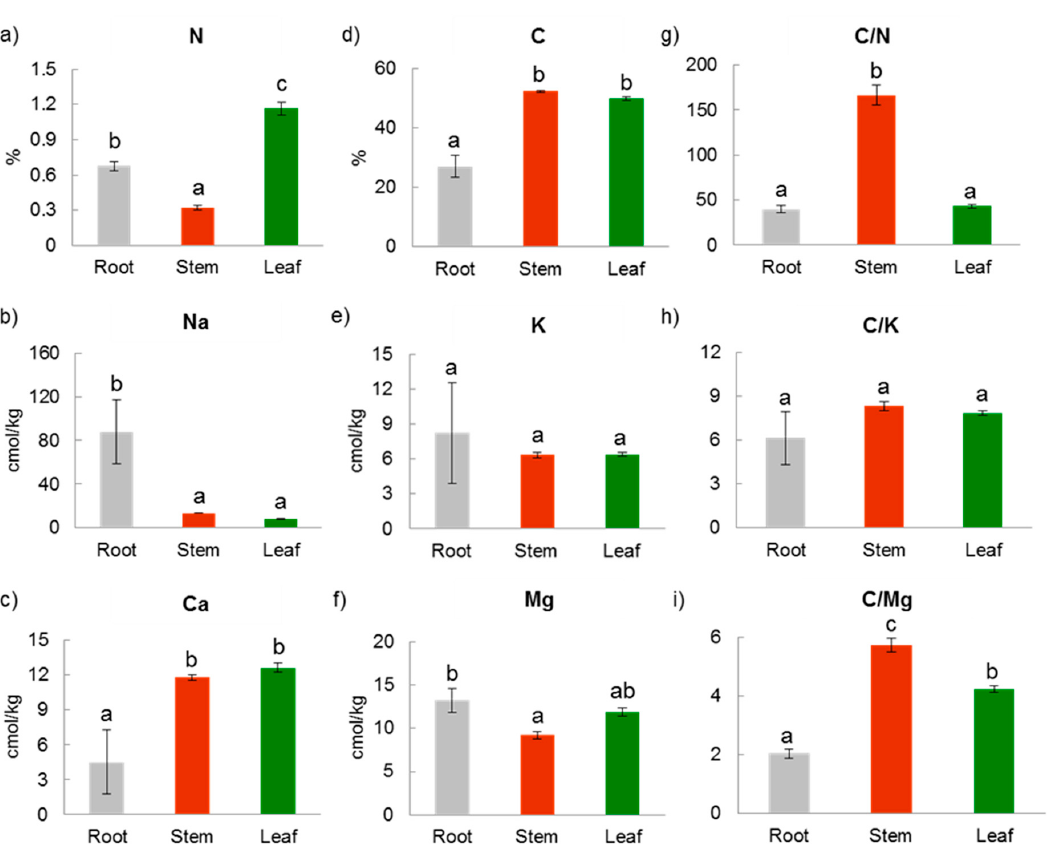
Figure 3. Measured values in root, stem, and leaf compartments of: ( a ) nitrogen (N), ( b ) sodium (Na), ( c ) calcium (Ca), ( d ) carbon (C), ( e ) potassium (K), ( f ) magnesium (Mg) contents, ( g ) carbon/nitrogen (C/N) ratio, ( h ) carbon/potassium (C/K) ratio, and ( i ) carbon/magnesium (C/Mg) ratio (means ± SE). Different letters above bars within panels indicate significant differences ( p < 0.05) according to one-way analysis of variance (ANOVA).